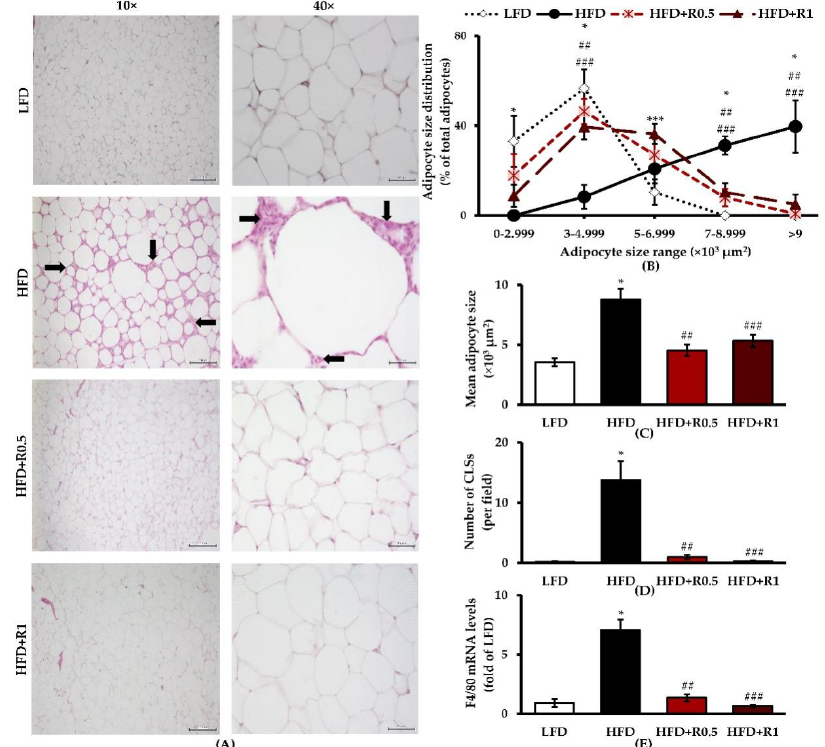
Figure 2. Effects of RRBE on adipose tissue morphology and inflammatory cell accumulation in HFD-fed mice: ( A ) representative microscopic pictures of H&E staining in eWATs; arrows indicate representative pictures of CLSs; left column, magnification 10×; scale bar = 200 μ m; right column, magnification 40×; scale bar = 50 μ m; ( B ) adipocyte size distribution; ( C ) mean adipocyte size; ( D ) number of CLSs in eWATs; ( E ) F4/80 mRNA expression. Data are presented as means ± SEM of 6 mice per group and were analyzed by one ‐ way ANOVA followed by Tukey’s post hoc test. *, *** p < 0.05 for HFD and HFD + R1 groups versus LFD group; ##, ### p < 0.05 for HFD + R0.5 and HFD + R1 groups versus HFD group, respectively.